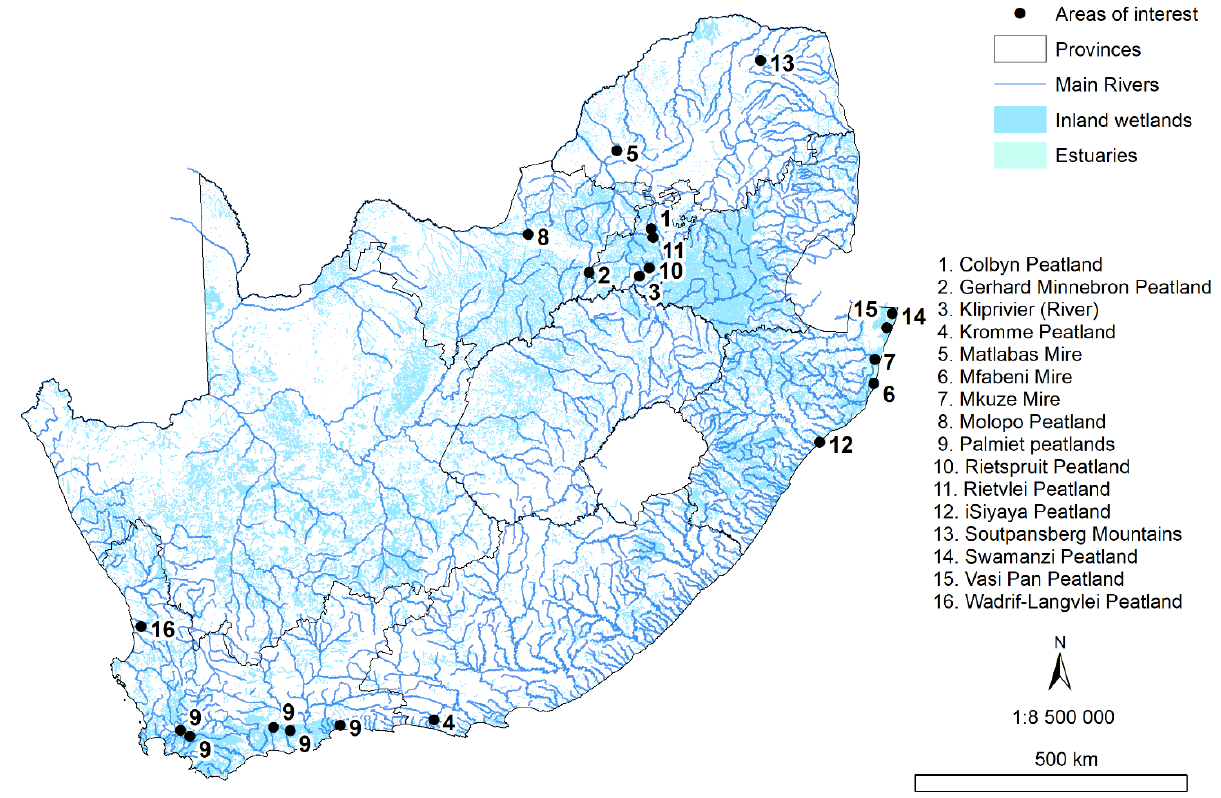
Figure 2. Areas of interest related to the peatlands of South